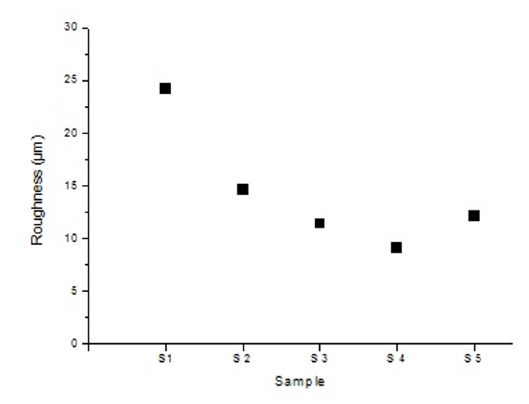
thin films on steel 2